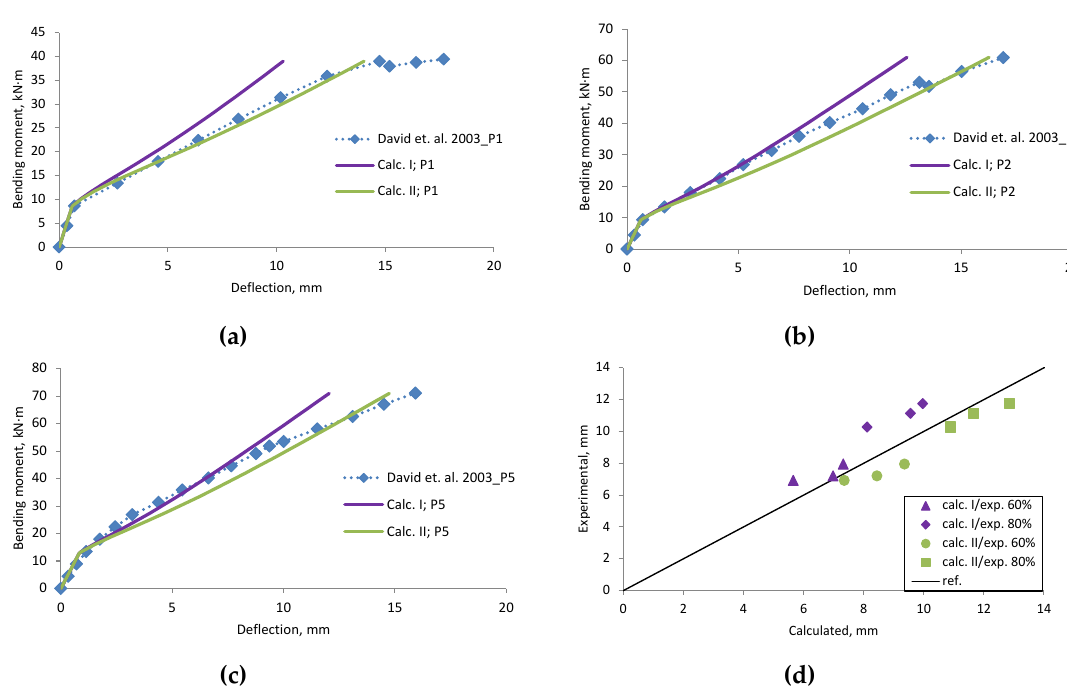
Figure A3. David et al., 2003 [26] research beams deflection compared with calculated, ( a ) beam P1; ( b ) beam P2; ( c ) beam P5; ( d ) scatter of the results at 60% and 80% of the ultimate load.